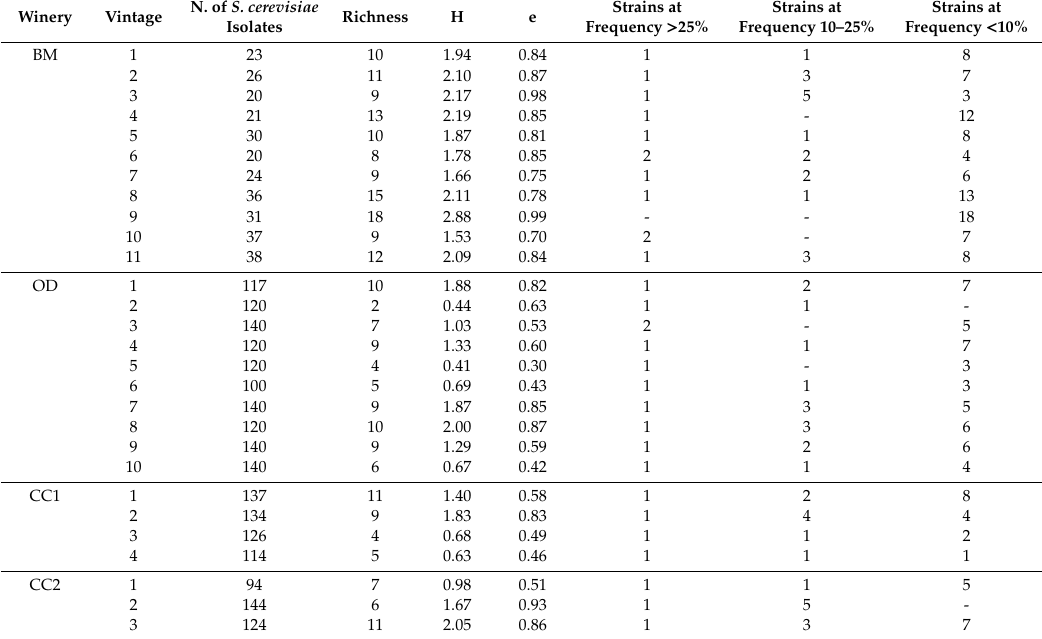
Table 2. The biodiversity of S. cerevisiae strains occurring in Tuscany wineries located in three di ff